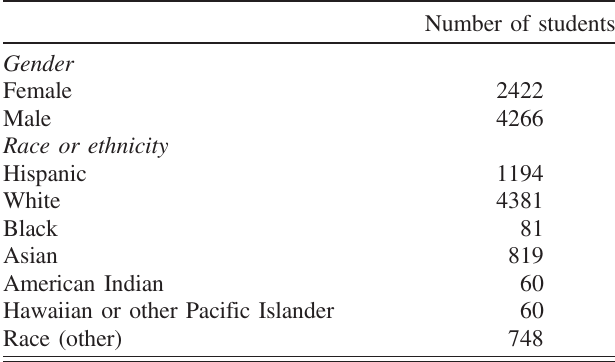
TABLE I. Self-reported gender, race, and ethnicity of students in the LASSO dataset. Students may select more than one race option on the survey. In this table the race categories are presented as a sum of the reported within category. Thus the total sum of reported races is greater than the total number of students ( N ¼ 6688 ) due to students identifying as more than one race.